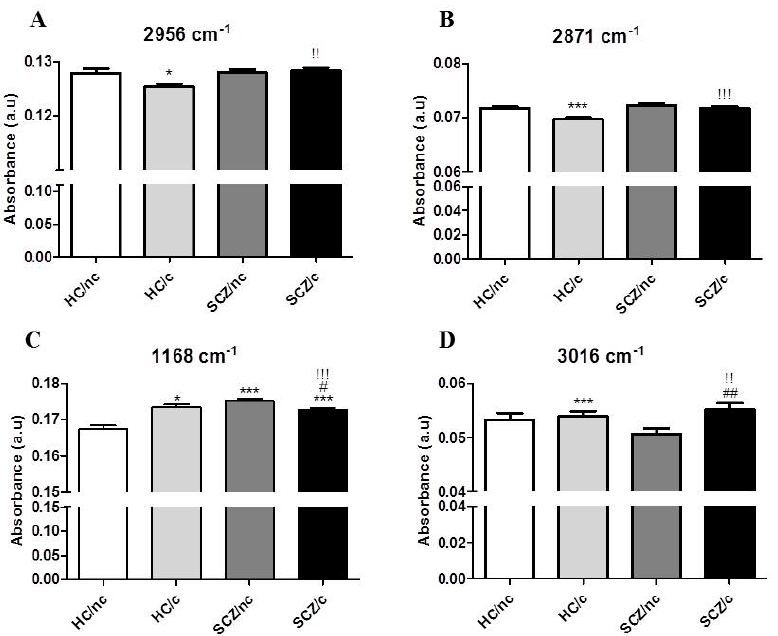
Figure 3. Major peak amplitudes related to the CH3 ( A ) 2956 cm − 1 , ( B ) 2871 cm − 1 , ( C ) the cholesteryl esters 1168 cm − 1 and ( D ) the aromatic cys-alkelene (HC=CH) group 3016 cm − 1 in ON cells from healthy controls non-cannabis users (HC/nc); healthy controls cannabis users (HC/c); schizophrenic patients non-cannabis users (SCZ/nc) and schizophrenic patients cannabis users (SCZ/c). The data are expressed as means ± S.E.M. * p < 0.05; ** p < 0.01; *** p < 0.001 vs. HC/nc. ! p < 0.05; !! p < 0.01; !!! p < 0.001 HC/c vs SCZ/nc. # p < 0.05; ## p < 0.01; ### p < 0.001 SCZ/nc vs SCZ/c.